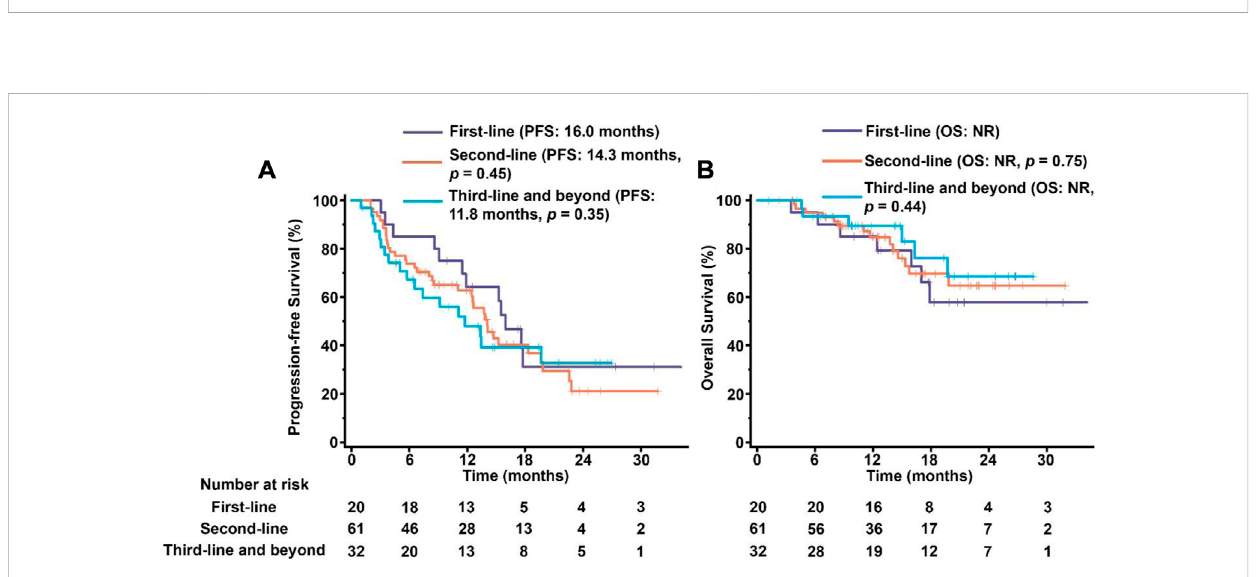
FIGURE 4 PFS (A) andOS (B) inpatientstreatedbypyrotinibas fi rst-line,second-line,third-lineandbeyondmedicine.Thetickmarksindicatethetimepointsat which the data were censored. NR, not